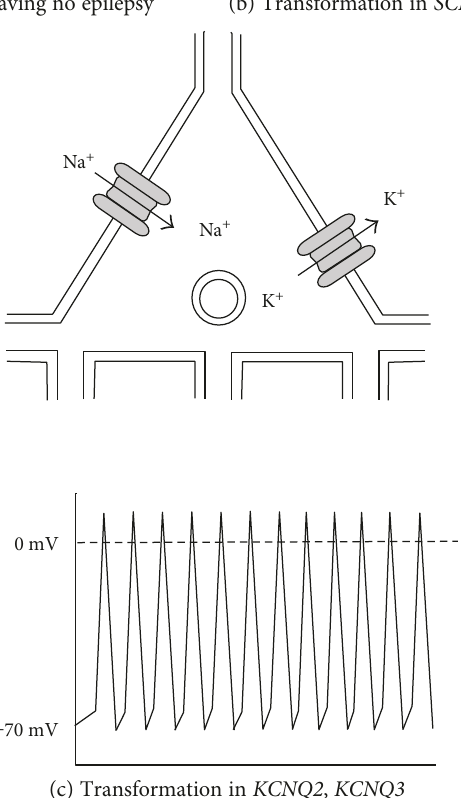
Figure 1: Ion-channel dysfunction for the formation of